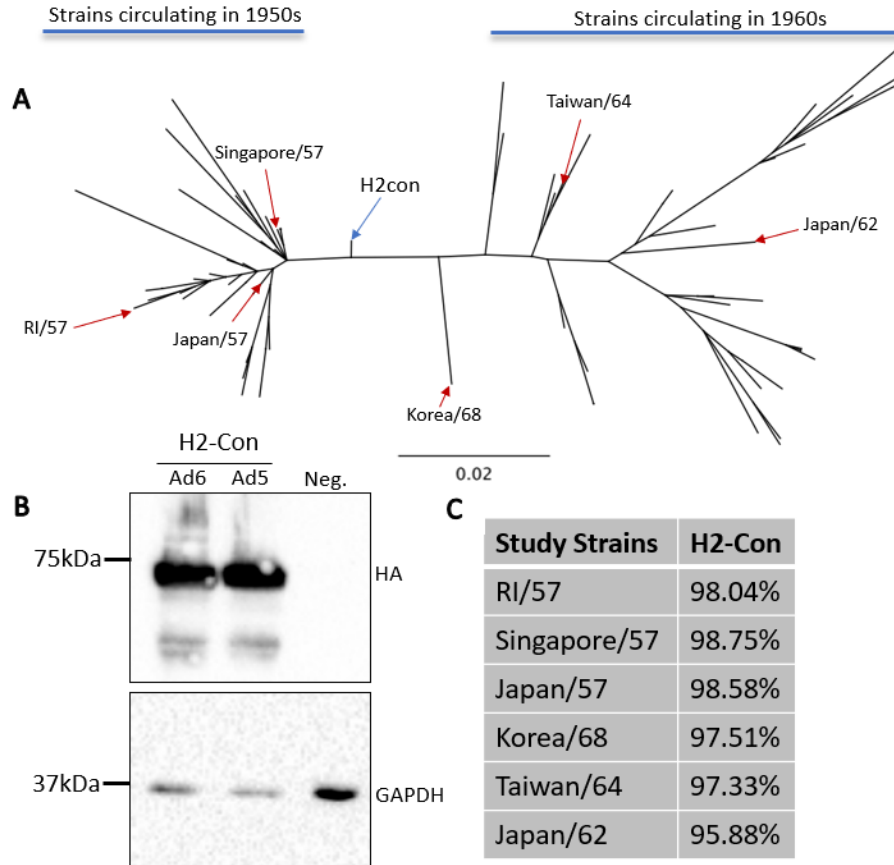
Figure 1. Characterization of centralized consensus human H2 immunogen and study strains. ( A ) The genetic relationships between the centralized consensus and wildtype H2 influenza A virus strains are shown in an unrooted neighbor-joining phylogenetic tree. H2-Con (blue arrow) localizes to the center of all human H2 strains isolated between 1957 and 1968. Reference strains isolated from 1957 to 1964 (red arrows) and used in this study are labeled on the tree. ( B ) Western blot analysis of H2-Con (~72 kDa) in Ad6 and Ad5 viral vectors from two independent experiments. GAPDH (~33 kDa) was probed as a cellular loading control. ( C ) Percent sequence similarity of the wildtype strains used in the study compared to H2-Con.